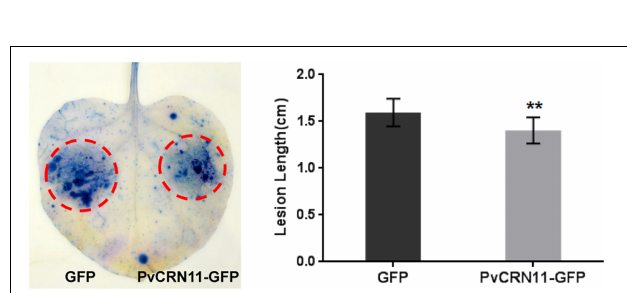
FIGURE 9 | The PvCRN11 gene enhanced the resistance of N. benthamiana to P. capsici when transiently expressed in N. benthamiana. Left panel : representative inoculated N. benthamiana leaves stained with trypan blue. The lesions are outlined with red circles. Right panel : mean lesion lengths of N. benthamiana leaf regions in which PvCRN11 or the control GFP were expressed. The heights of rectangles represent the mean lesion lengths. Error bars represent SD of nine samples. Asterisks indicate significant differences from the control groups (paired t -test; ** p < 0.01). Similar results were obtained in three independent